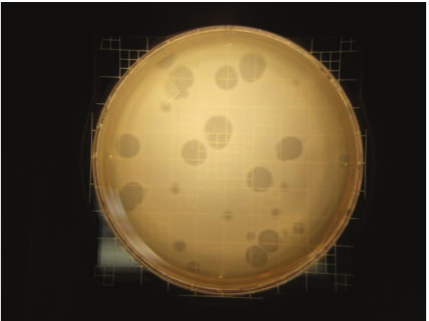
Figure 5: Plaques are readily visible from the assay of Bacteriovorax isolates on a lawn of V. parahaemolyticus host cells after incubation for 7 days. Larger plaques are approximately 1cm in diameter in this image. Medium is Pp20 agar as indicated in Materials and